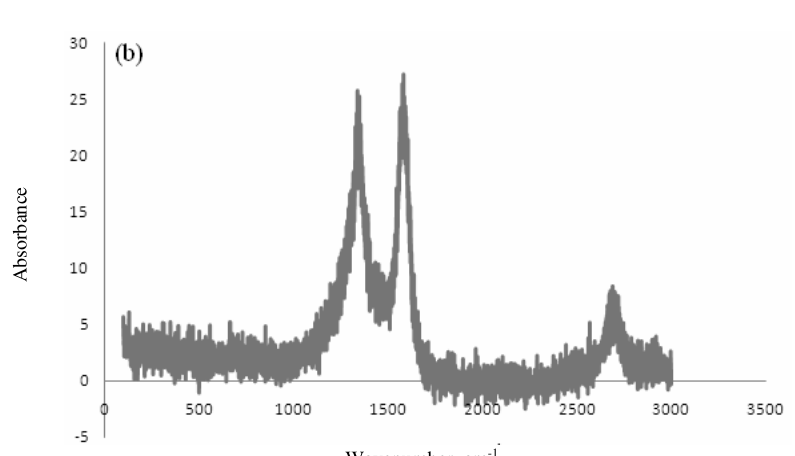
Figure 1. Raman spectra of carbon nanotube grown over (a) Co/Zn/Al and (b) Fe/Ni/Al catalyst